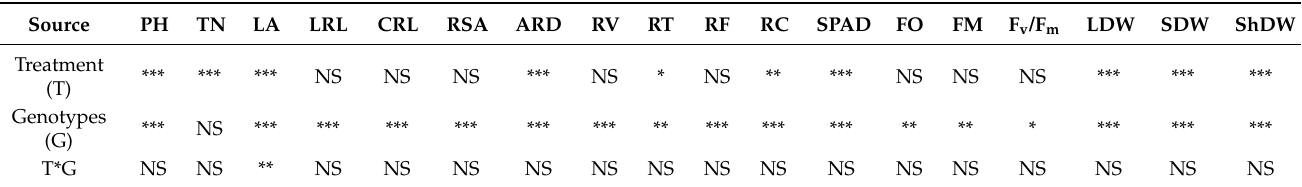
Table 1. Analysis of variance across the 74 tropical rice genotypes (G), drought treatment (T), and their interaction (T*G) for the morpho-physiological traits measured at the final harvest, 36–37 days after